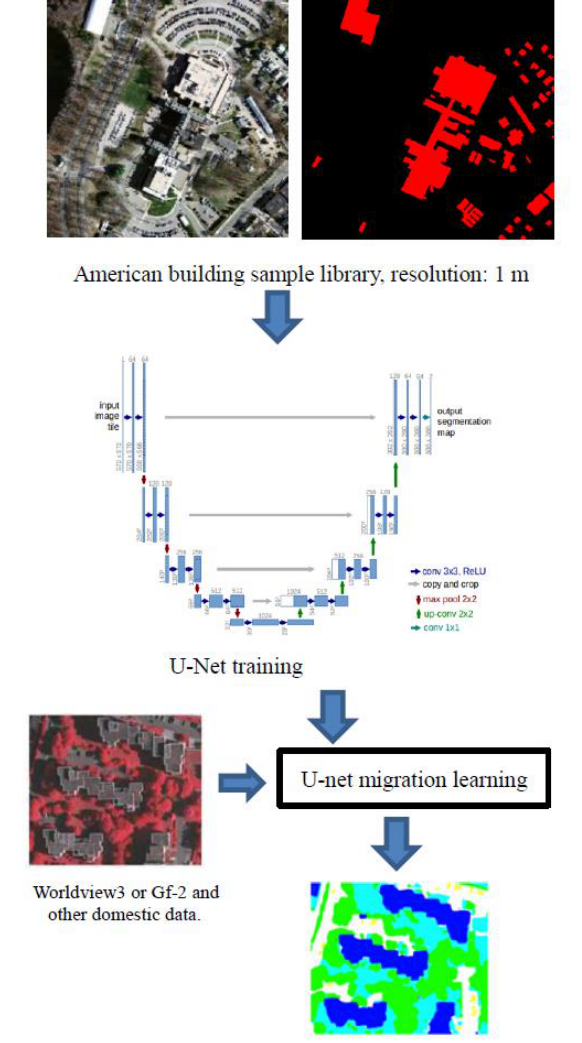
Figure 4. Process of model training and